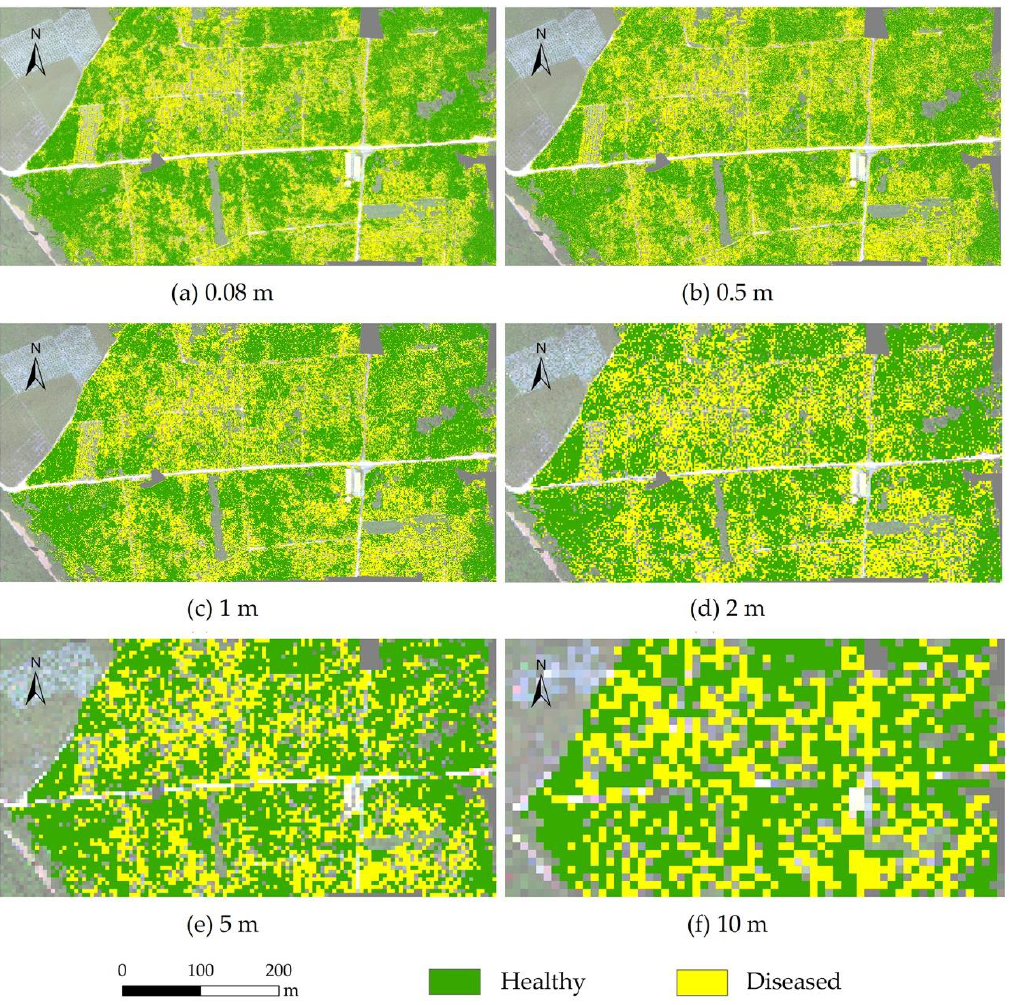
Figure 2. Maps of the distribution of banana Fusarium wilt at Guangxi site based on the CI RE for di ff erent resolutions. ( a ) 0.08-m resolution; ( b ) 0.5-m resolution; ( c ) 1-m resolution; ( d ) 2-m resolution; ( e ) 5-m resolution; ( f ) 10-m resolution. Table 5. Area and percentage of the Fusarium wilt infected regions based on di ff erent resolution maps. Resolution Healthy Area (ha) Diseased Area